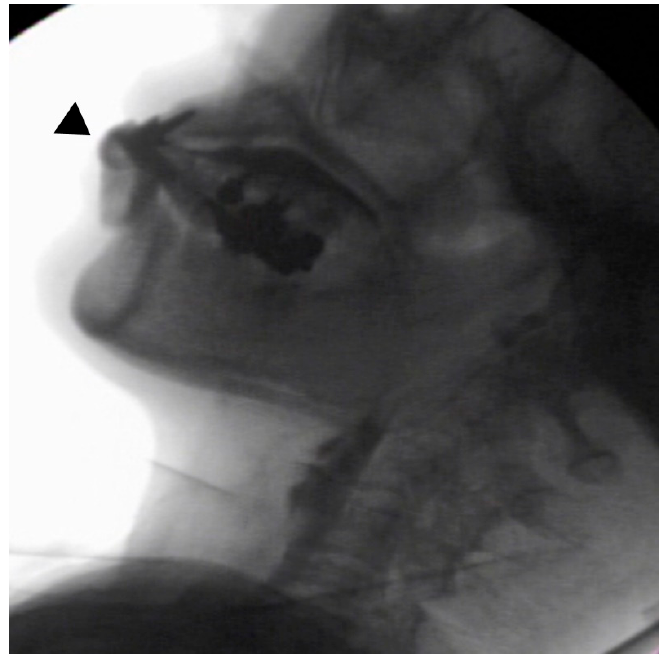
Figure 3. The patient was reclined at 30° for the administration of 7 mL of an extremely thick paste. Even when the food was placed in the retromolar area, most of the food dribbled out of her mouth ( ▲ ) upon triggering her swallowing reflex.